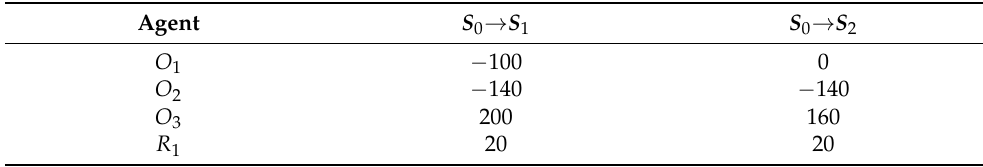
Figure 6. A fragment of agent negotiation aimed at resolving conflicts. Table 6. The change of agent budgets in transition between